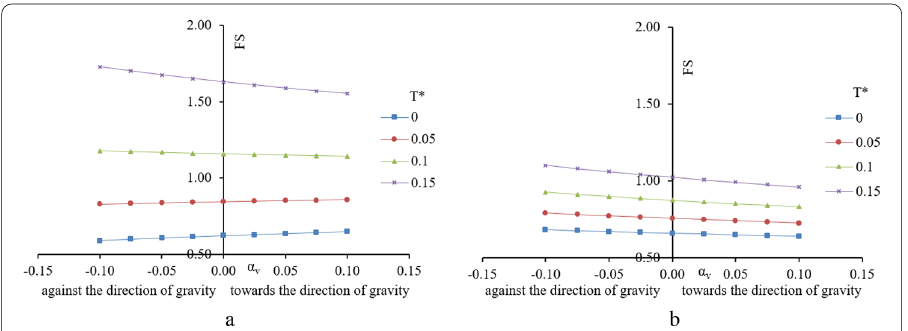
Fig. 10 FS vs α v on different values of T *: a case 1 and b case